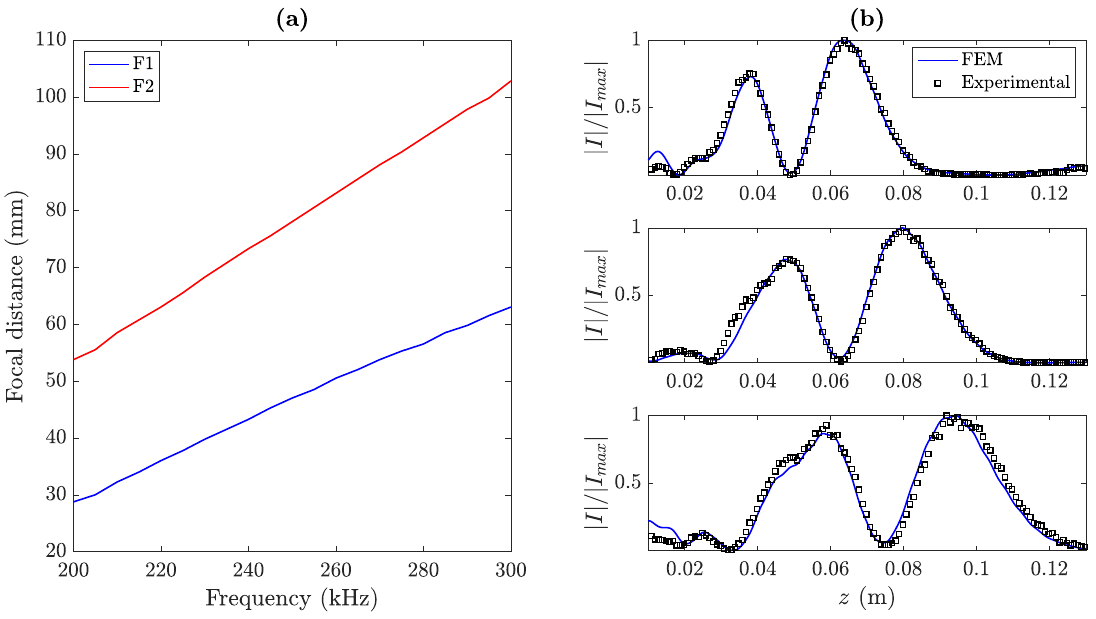
Figure 8. ( a ) BiFZP focal distance for F (cid:48) and ( b ) BiFZP focusing profiles at 220 kHZ (top), 250 kHz (middle) and 280 kHz